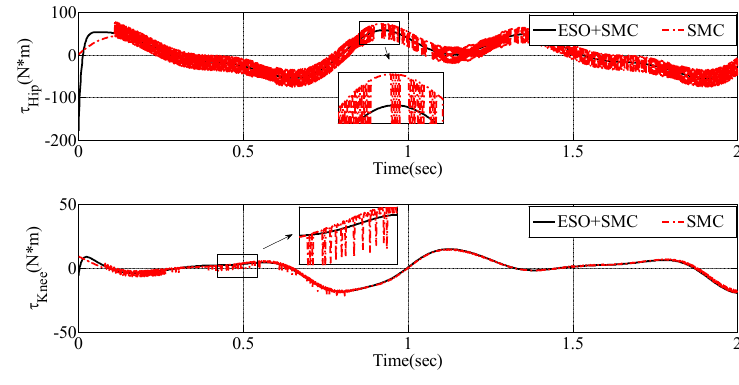
Figure 14. Comparison of sliding mode controllers.